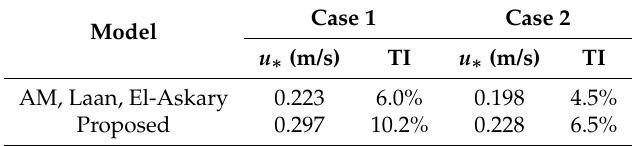
Table 3. Test cases and corresponding parameters under stable conditions.